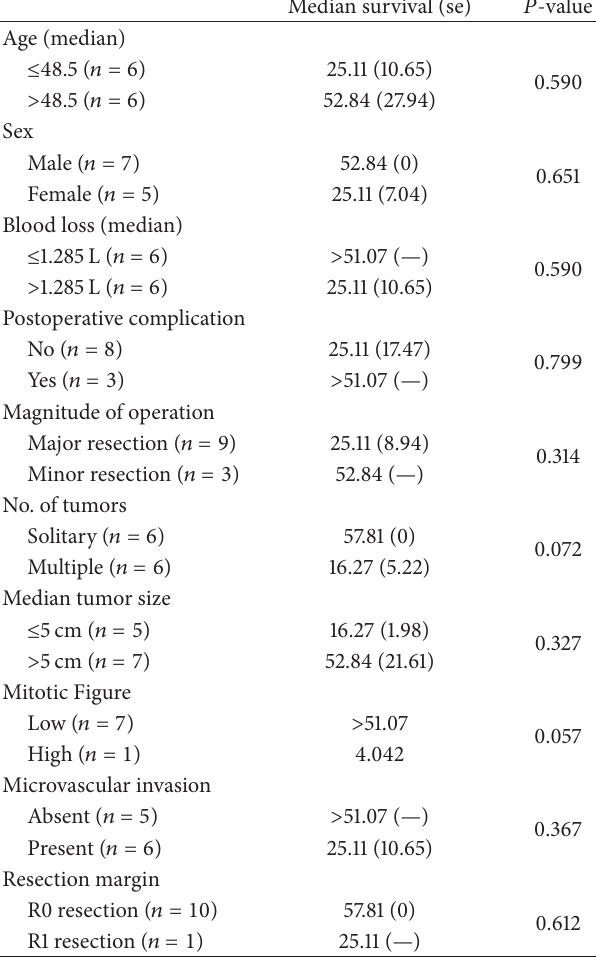
Table 4: Univariable analysis of factors affecting overall